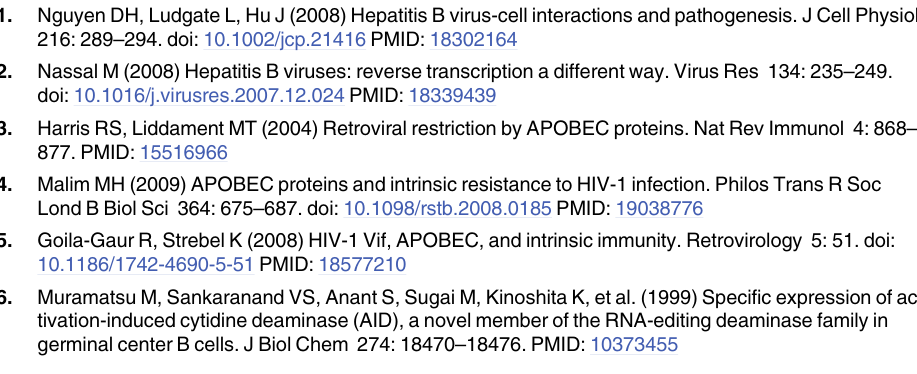
S8 Fig. Knocking down of ZAP expression did not affect AID-mediated downregulation of HBV transcripts. Huh7 cells were transfected with an AID (or GFP) expression vector with in- dicated siRNA together with pPB. Cells were harvested after 3 days of incubation. Levels of ZAP expression and HBV RNA were determined by RT-qPCR. siZAP-1 and -2 were obtained from Invitrogen. siZAP-3 [37] was obtained from Santa Cruz Biotechnology. (A) Fluorescence microscopic image of GFP transfectants on day 3 after transfection. Knocking down of GFP ex- pression is obvious in siGFP transfectants. (B) ZAP mRNA expression levels. The expression level of ZAP in the GFP-transfected, GFP siRNA (siGFP)-transfected (far right) was defined as one. (C) HBV RNA levels: HBV RNA level in the GFP-transfected, GFP siRNA (siGFP)-treated (far right) was defined as one. AID expression reduces HBV RNA levels in both siZAP and siGFP transfectants. (D) HBV RNA levels: The same data set in (C) was plotted with HBV RNA levels in siGFP-AID and siGFP-GFP transfectants defined as one. Knocking down of ZAP increases HBV RNA levels in both AID and GFP transfectants. (cid:2)(cid:2) P < 0.01 ( t -test), error bars represent standard errors of the mean. S1 Table. List of plasmids used in this study. S2 Table. List of primers used in this study. S3 Table. List of Genbank accession numbers used in this